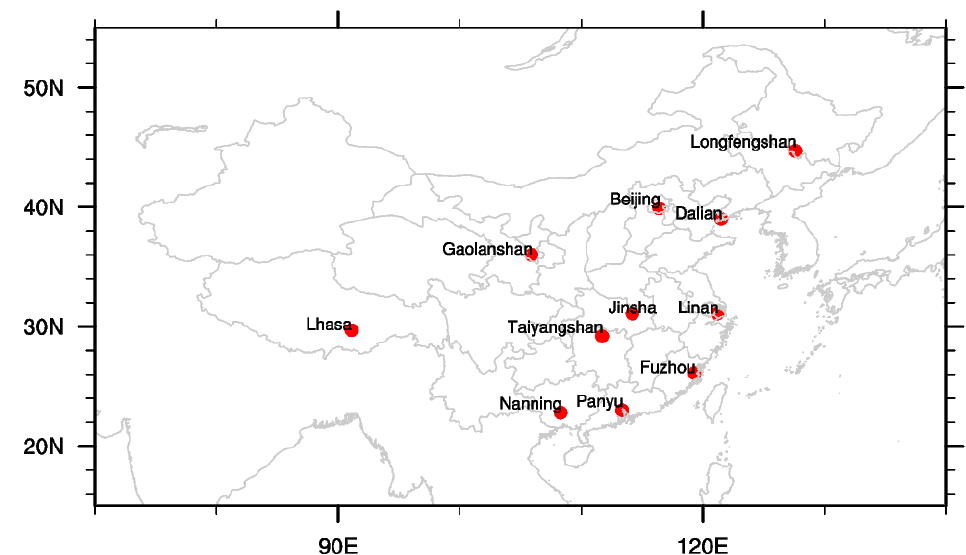
Figure 3. Locations of surface observations sites .